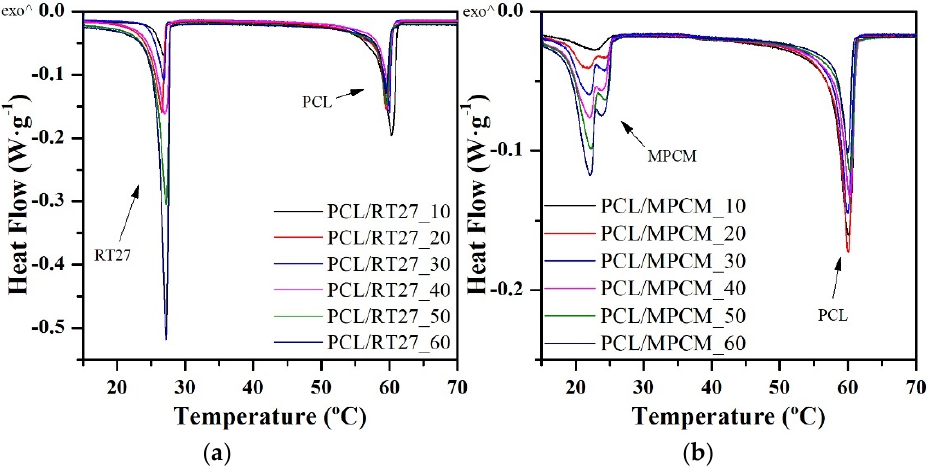
Figure 2. ( a , b ) Heat flow curves of RT27 and MPCM blends, respectively.